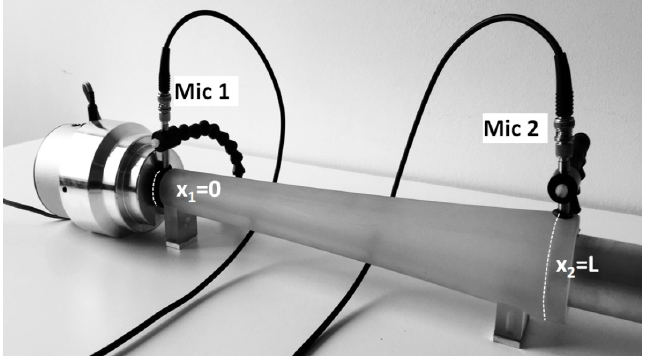
Figure 9. Exponential horn with length L = 410 mm, D 0 = 10 mm, D L = 45 mm, manufactured with rapid prototyping (accuracy 50 µ ), wall thickness 15 mm [23].